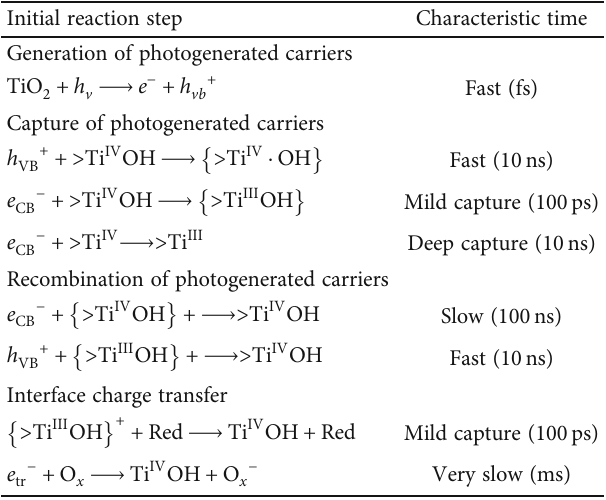
Table 3: Primary processes and characteristic time domains for photocatalysis on TiO 2